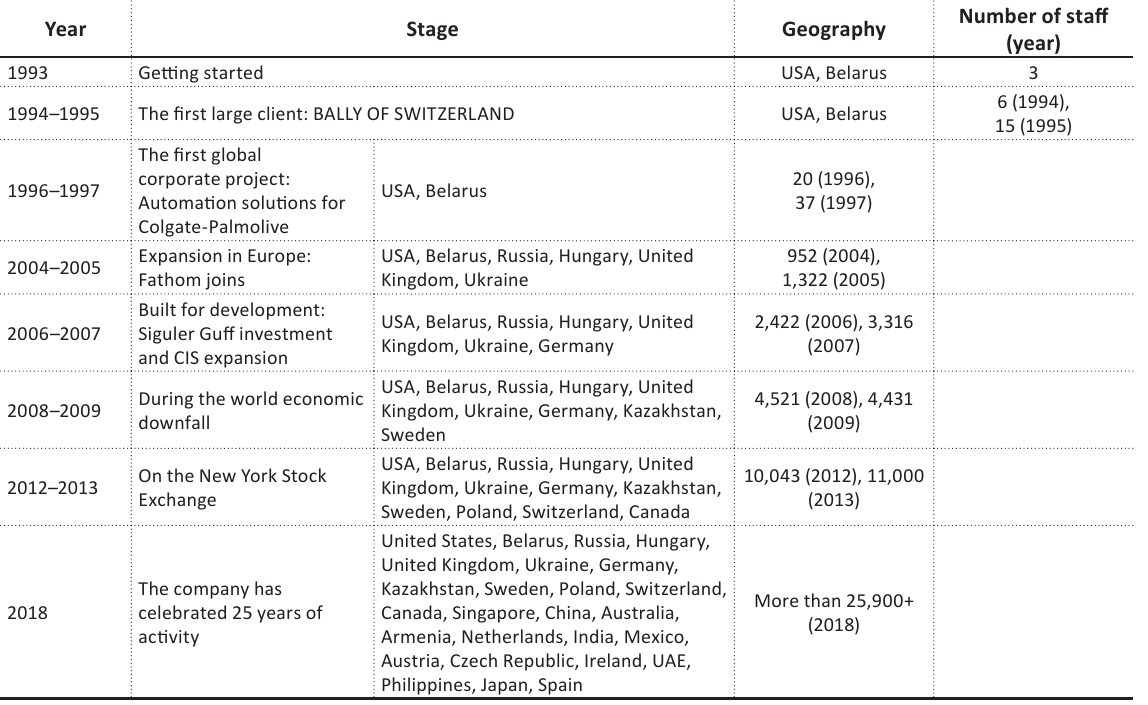
Table 2. Sigma Software development